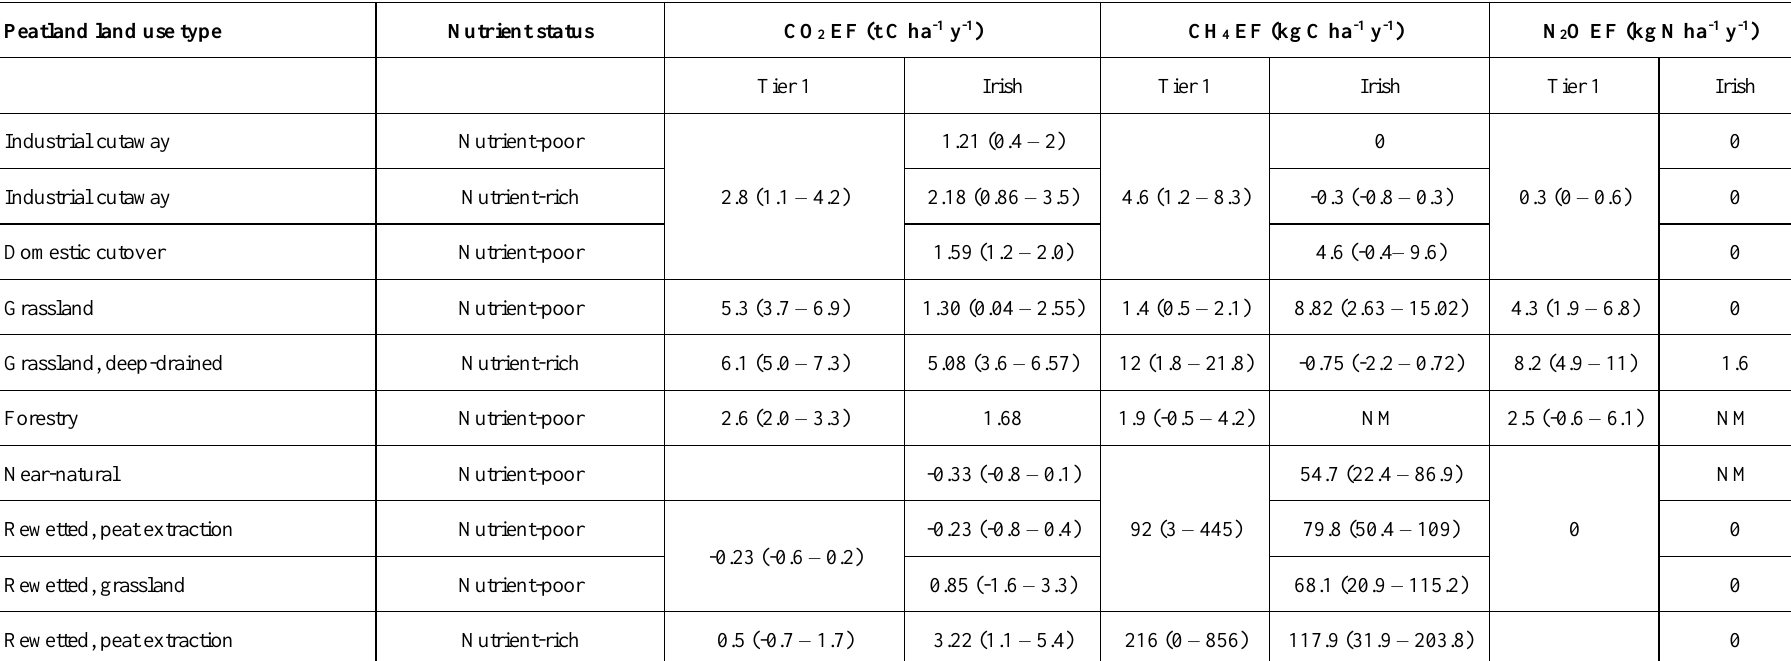
Table 2. Carbon dioxide (CO 95 % confidence intervals (values in brackets). Default Tier 1 EF values are taken from Tables 2.1, 2.3, 2.5 and 3.3 in the 2013 IPCC Wetlands Supplement. NM = not